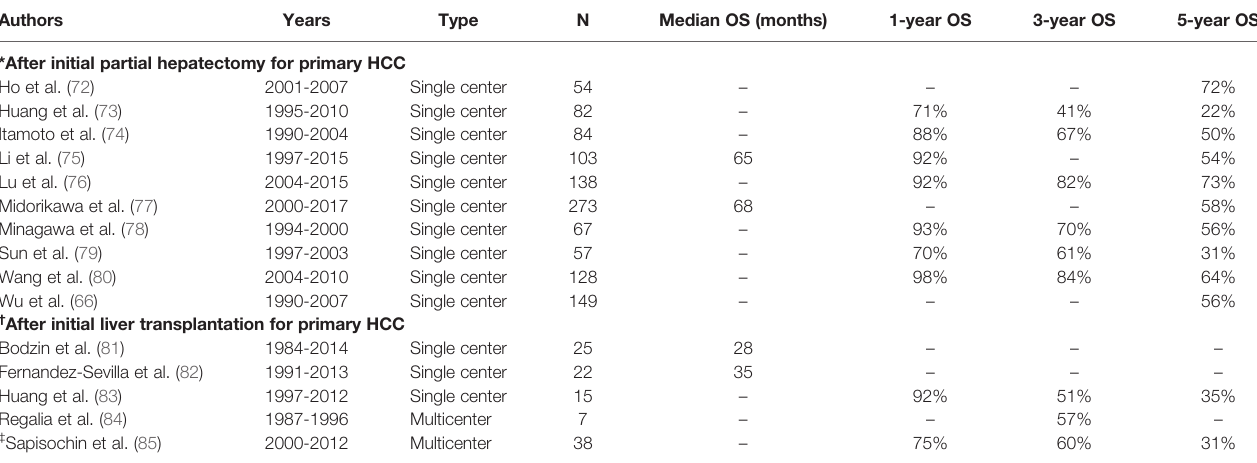
TABLE 2 | Survival after resection for hepatocellular carcinoma (HCC) recurrence in the